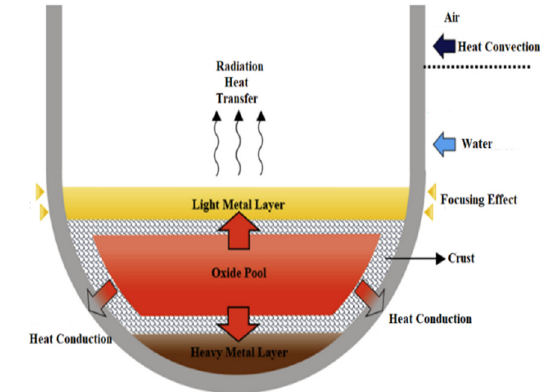
Fig.1: Three-layered core melt phenomenon [7] Light metal layer has high conductivity and affects magnitude of heat flux considerably. On reduction in metallic layer excess heat remaining after radiation, coming from oxide layer, is focused to RPV sidewalls, known as Focusing Effect [9]. So, the chance of penetration is large in focusing